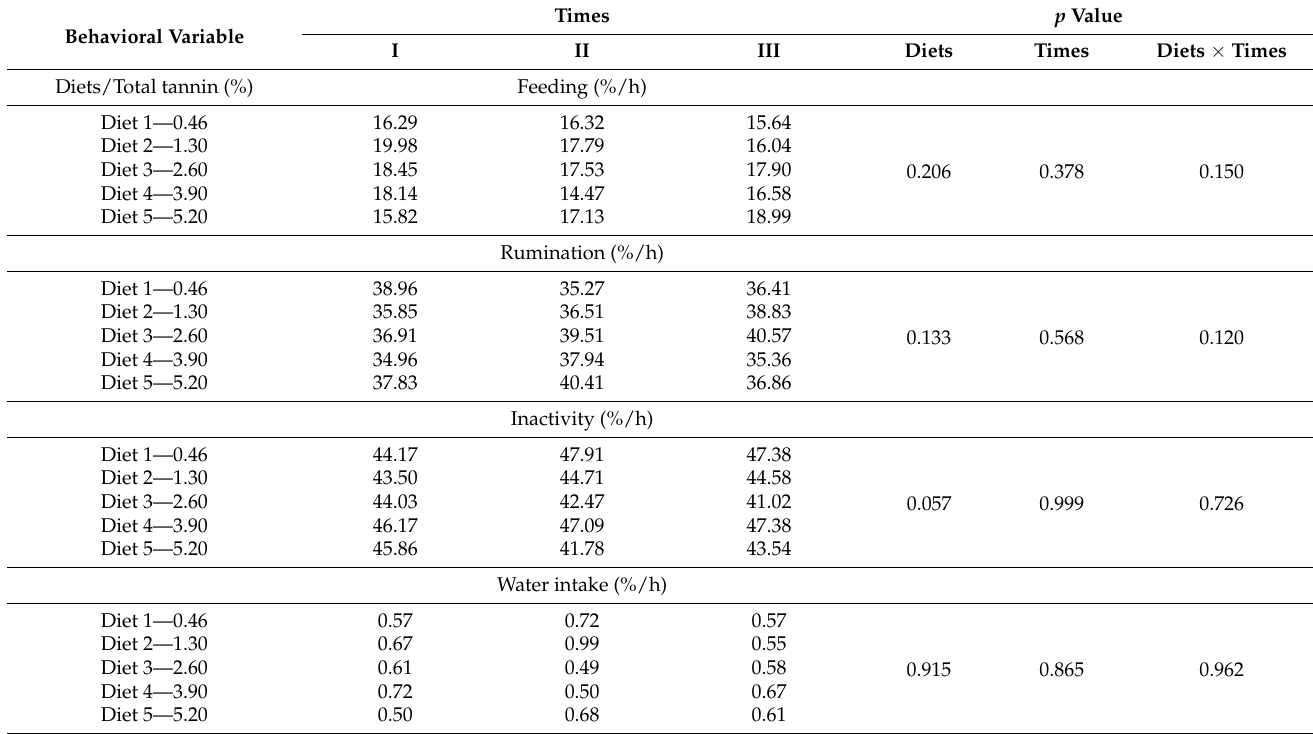
Table 1. A total daily time of feeding, rumination, inactivity, and water intake by lactating dairy cows as a function of dietary tannin levels, in three times of the study periods.